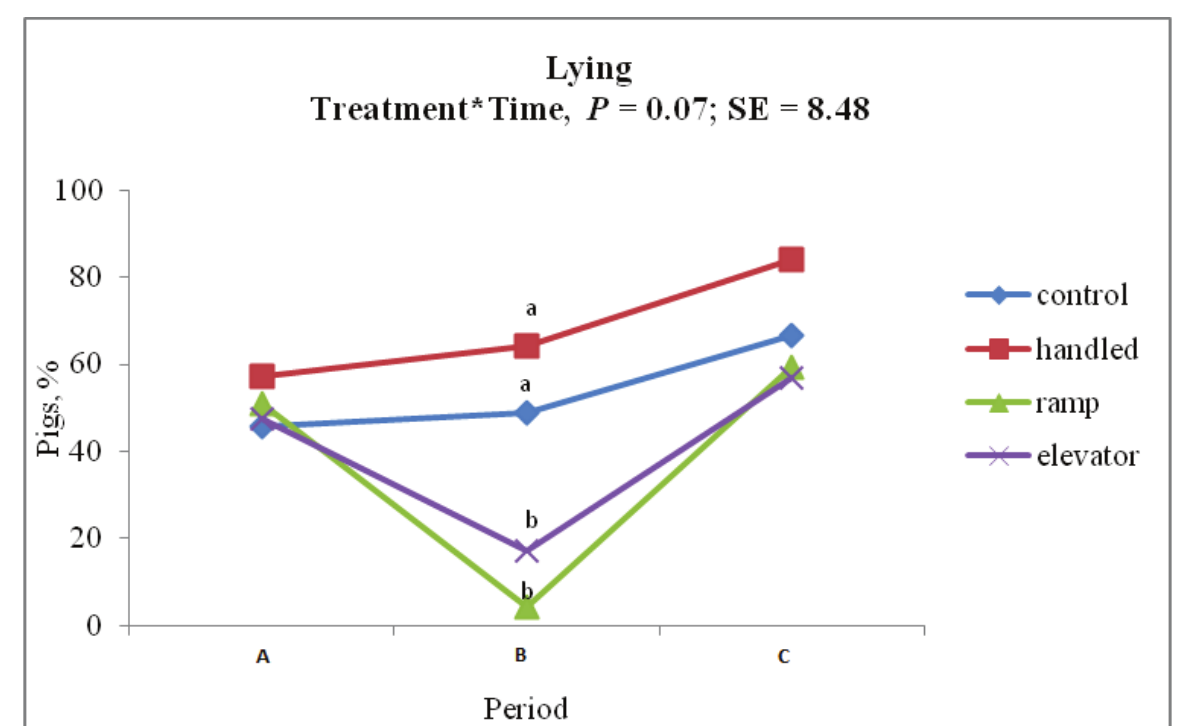
Figure 3. Percentage of pigs showing lying behavior an hour before (A), during (B) and after (C) each treatment (control, handling, ramp and elevator).